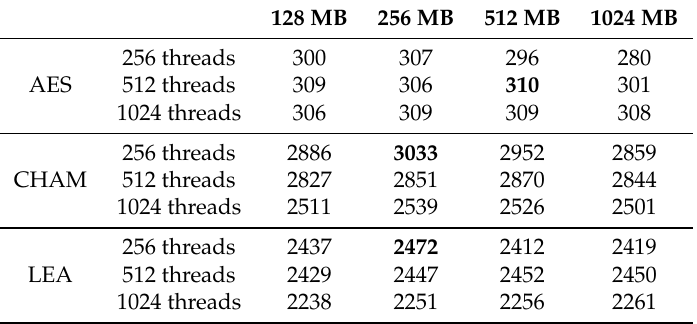
Table 7. Throughput by data size and the number of threads in RTX 2070